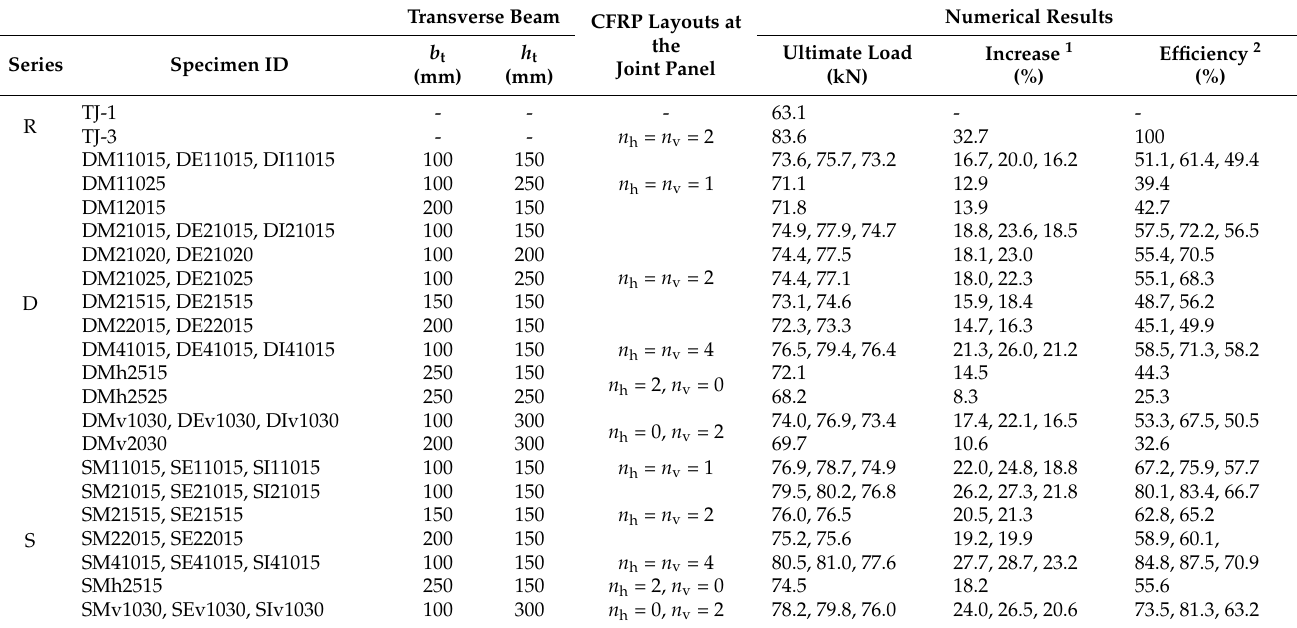
Table 1. Specimen details and nonlinear FE analysis